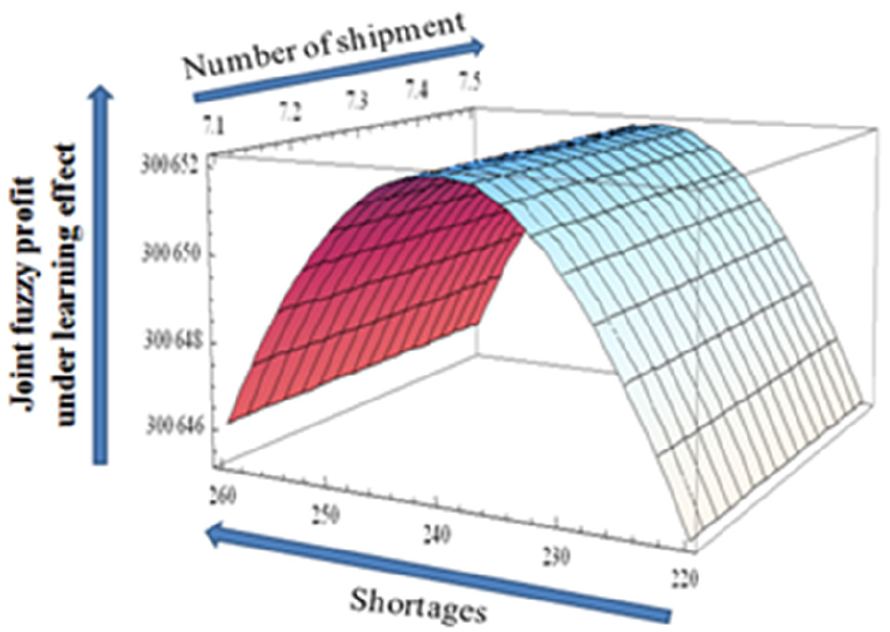
Figure 10. Concavity of the joint fuzzy profit with respect to the number of shipments and shortages under learning in a fuzzy environment.